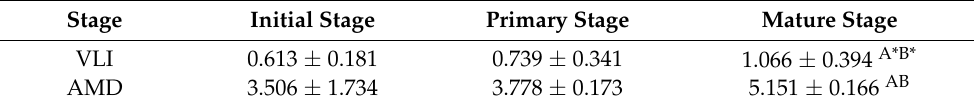
Table 9. Results of stage effect of muscle